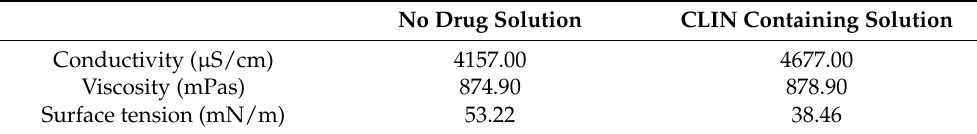
Table 1. Viscosity, conductivity, and surface tension of solutions for electrospinning. No Drug Solution CLIN Containing Solution Conductivity ( µ S/cm) 4157.00 874.90